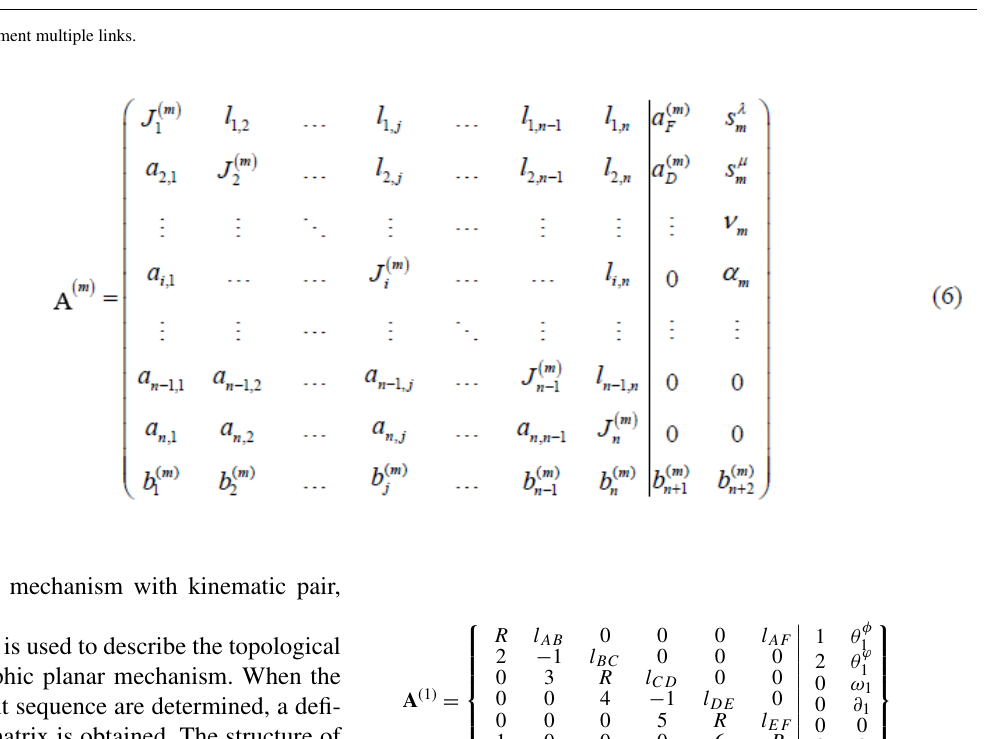
Table 3. The attribute of the links. The serial numbers of link The link